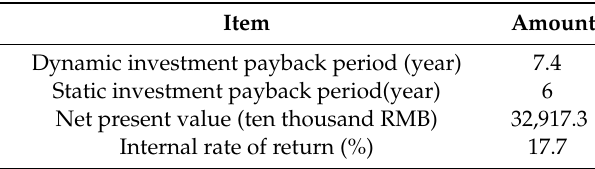
Table 5. Results of main economic indicators.